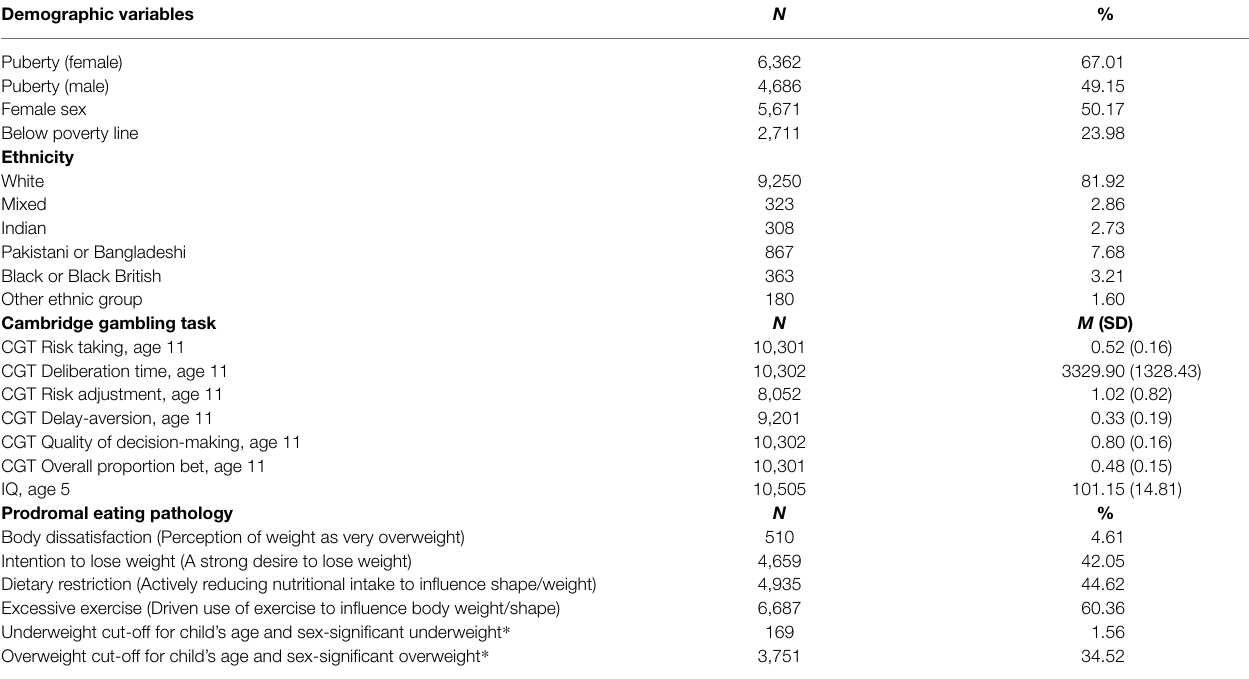
TABLE 1 | Descriptive statistics (unweighted data) in the analytic sample ( N = 11,303). Demographic